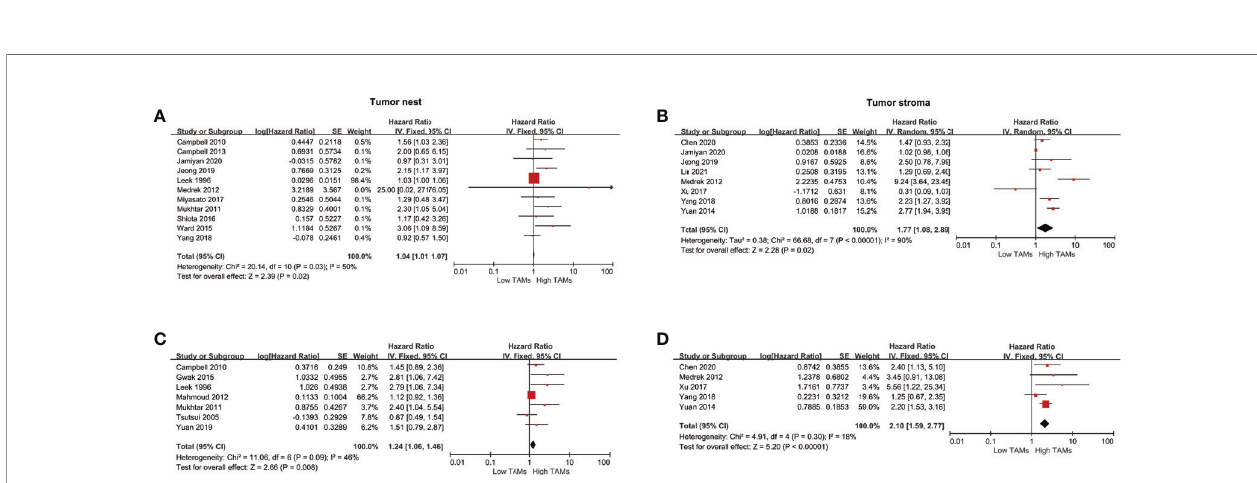
FIGURE 2 | Forest plots of HRs for OS between high and low CD68+ TAM density in BCa patients. (A) HRs of OS in raw data for CD68+ TAMs in the TN of BCa; (B) HRs of OS in raw data for CD68+ TAMs in the TS of BCa; (C) HRs of OS with adjusted measures for CD68+ TAMs in the TN of BCa; (C) HRs of OS with adjusted measures for CD68+ TAMs in the TS of BCa.